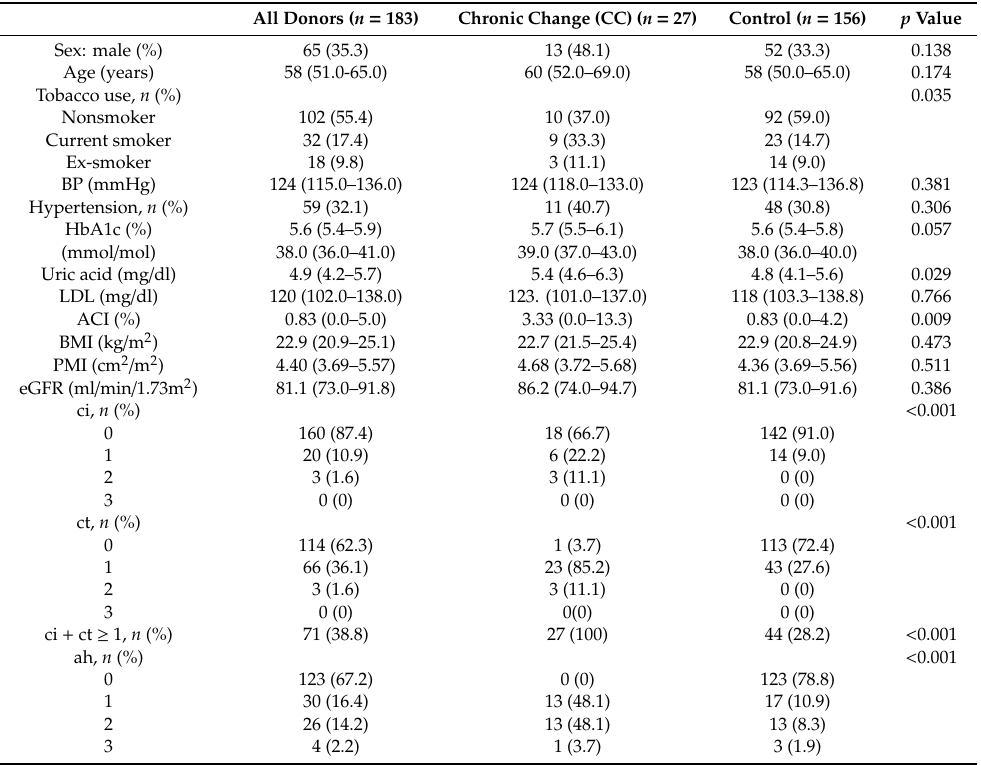
Table 1. Baseline